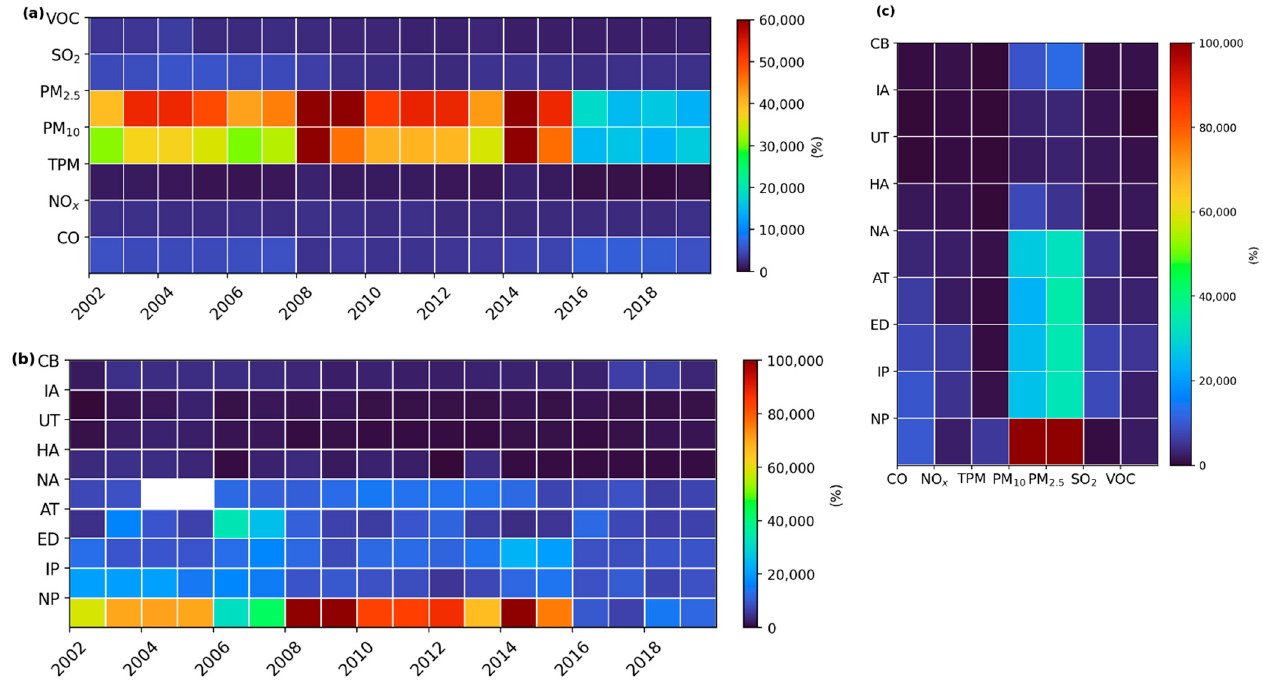
Figure 5. Mean difference from reporting thresholds (DRT) over ( a ) the sites, ( b ) the pollutants, and ( c ) the entire period. White represents no ( c ) the entire period. White represents no data.